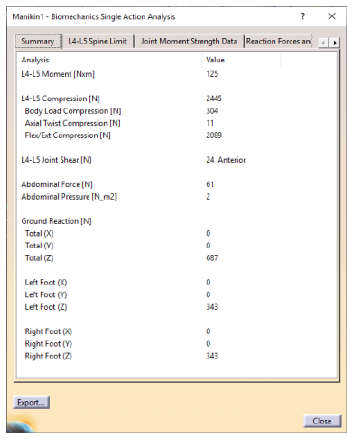
Figure 2. Results of biomechanical analysis for Figure 3. Results of the Rula analysis for the case m =70 kg and the slope of the workbench α =20 0 m =70 kg and the slope of the workbench α =20 0 Other results were analyzed and for all possible variants are presented in Table 1. Table 1. Loads in lumbar L4-L5 vertebrae with biomechanical and RULA